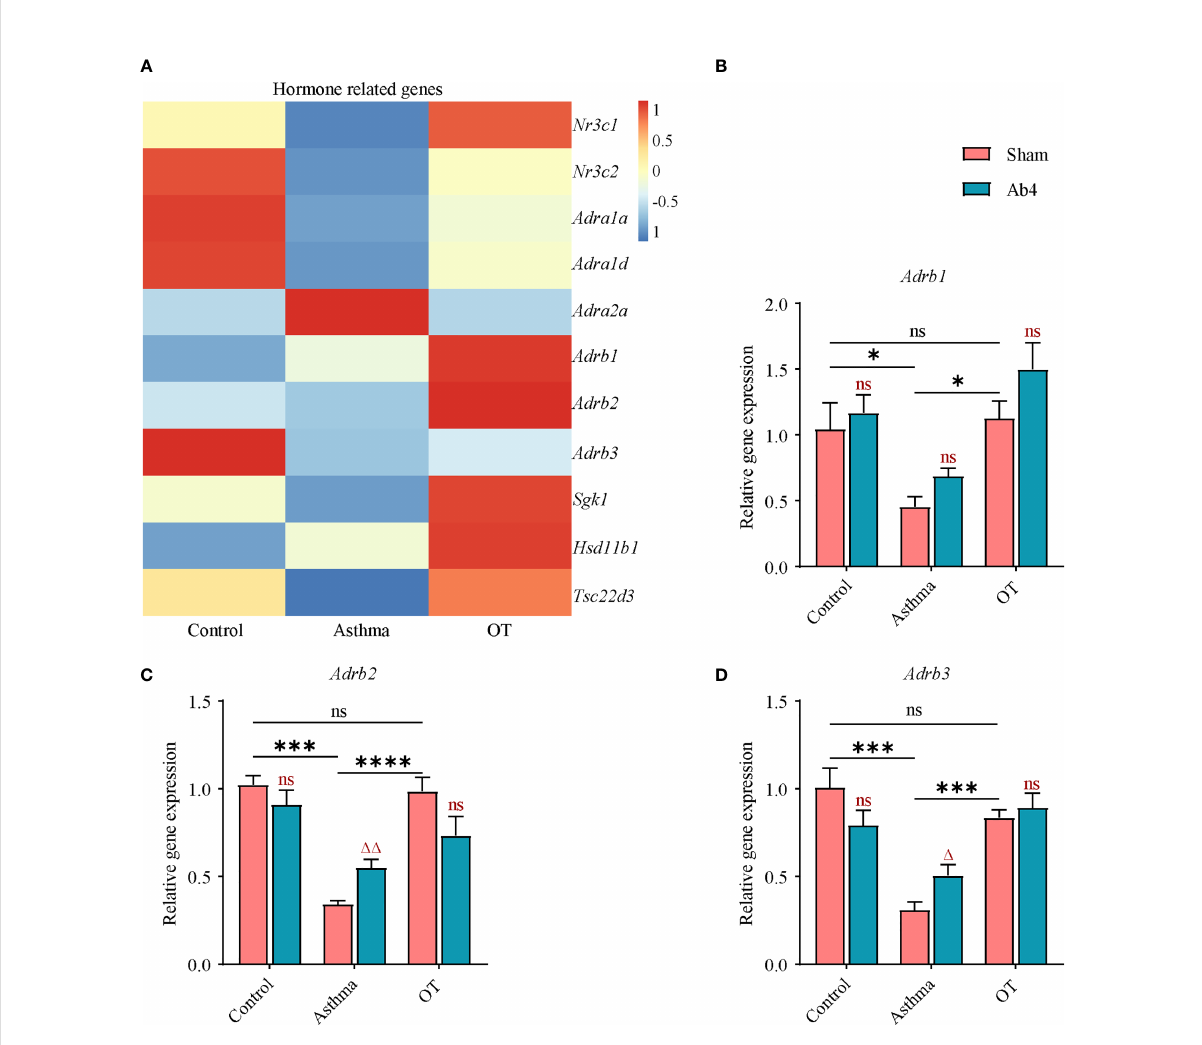
FIGURE 3 Adrb2 and Adrb3 genes are upregulated in asthmatic lungs after antibiotic treatment. (A) Heatmap showing the expression values (row normalization) of hormone-related genes in the control, asthmatic and OT lungs. The horizontal and vertical axes show the grouping information, and the gene name respectively (N = 3-4). (B – D) Gene expression levels of Adrb1, Adrb2 and Adrb3 in the whole lung of control, asthma and OT mice (with or without antibiotic treatment) were assessed by real-time qPCR (N = 4-5). Results are from one representative experiment of at least two independent experiments. All bars in this fi gure indicate mean ± SEM. * P < 0.05, *** P < 0.001, **** P < 0.0001 represent multiple comparisons of the control, asthma and OT groups (corrected by one-way ANOVA with Tukey ’ s test). △ P < 0.05 and △△ P < 0.01 represent comparisons of adjacent bars of Ab4 and sham in each group (unpaired two-tailed Student ’ s t-test); ns, not signi fi